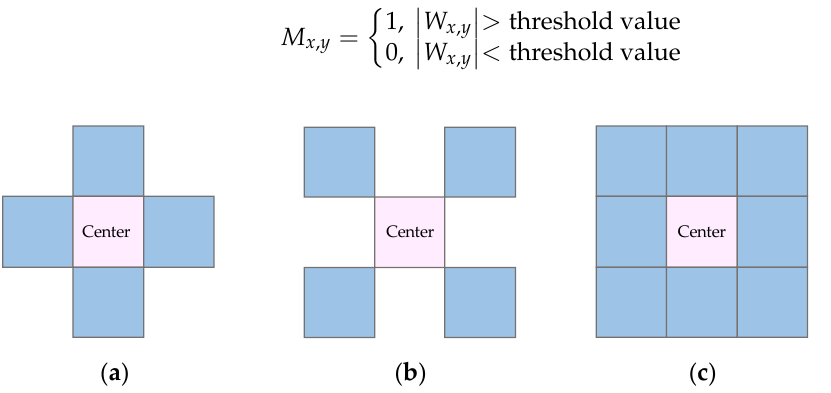
Figure 5. Diagram of 4-neighborhood and 8-neighborhood: ( a ) 4-neighborhood; ( b ) 4-diagonal neighborhood; ( c ) 8-neighborhood.